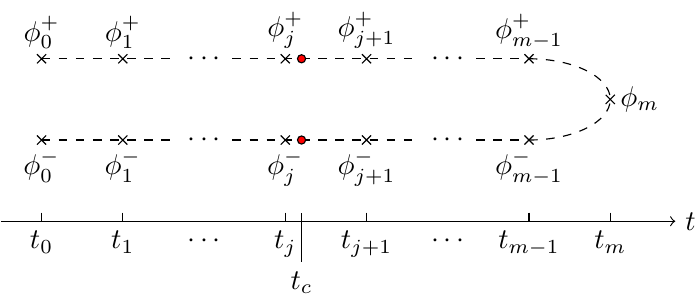
Figure 1 . Closed time path, C , used for solving the real-time path